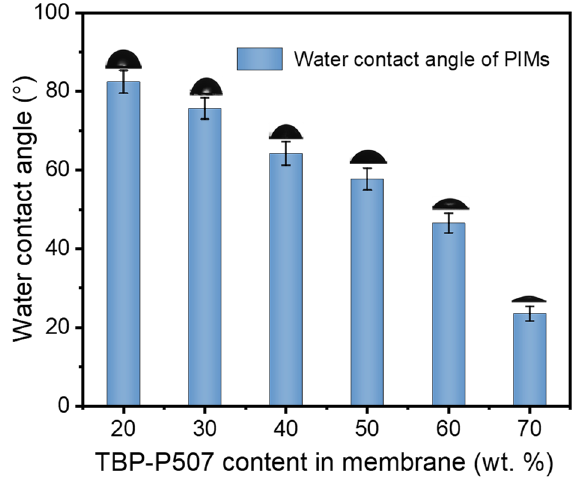
Figure 6. Water contact angles of the PIMs with different content of P507-TBP; n = 5.